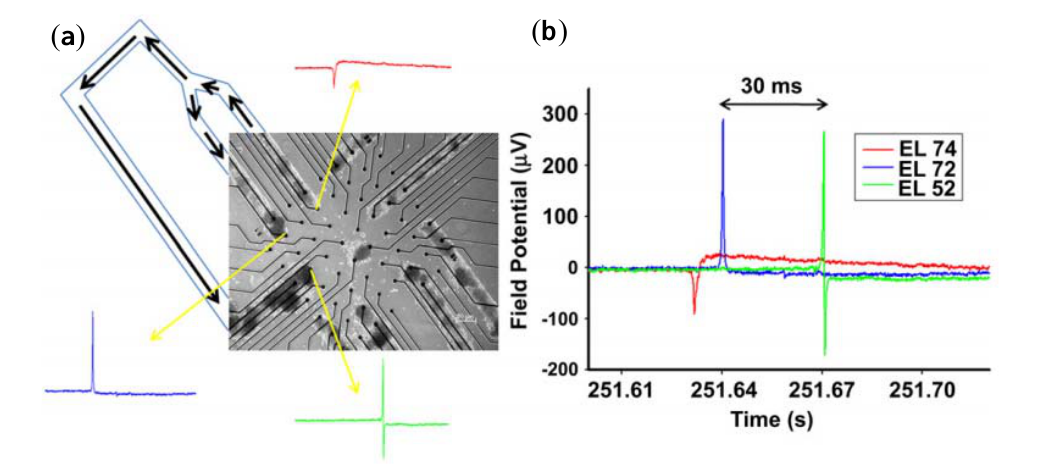
Figure 10. AP conduction in patterned cardiac myocyte monolayers. ( a ) Phase contrast picture of cardiac myocyte patterns on the top of the substrate embedded electrodes (electrode distance is 200 μ m) with a sketch of the conduction pathway on the completed pattern and with the recorded extracellular signals on the given electrodes; ( b ) Overlay of the recorded traces showing the temporal relationship of the signals. (Reprinted from [53]. © 2011, with permission from